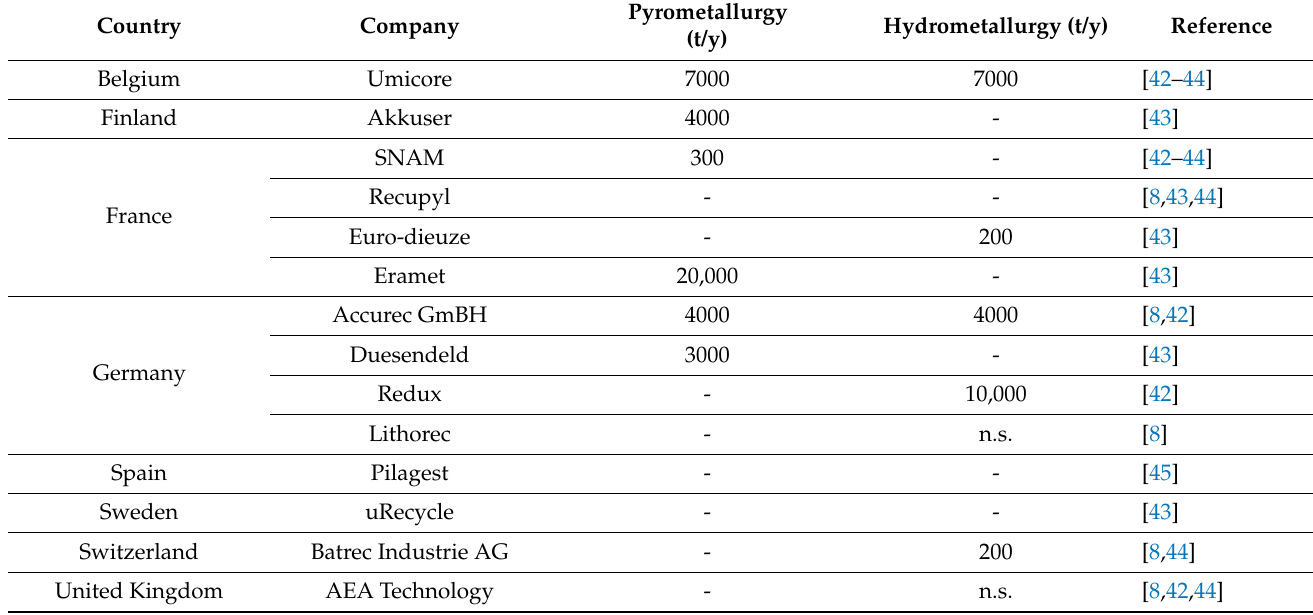
Table 2. Inventory of European LIBs’ recycling capacity (n.s.: not